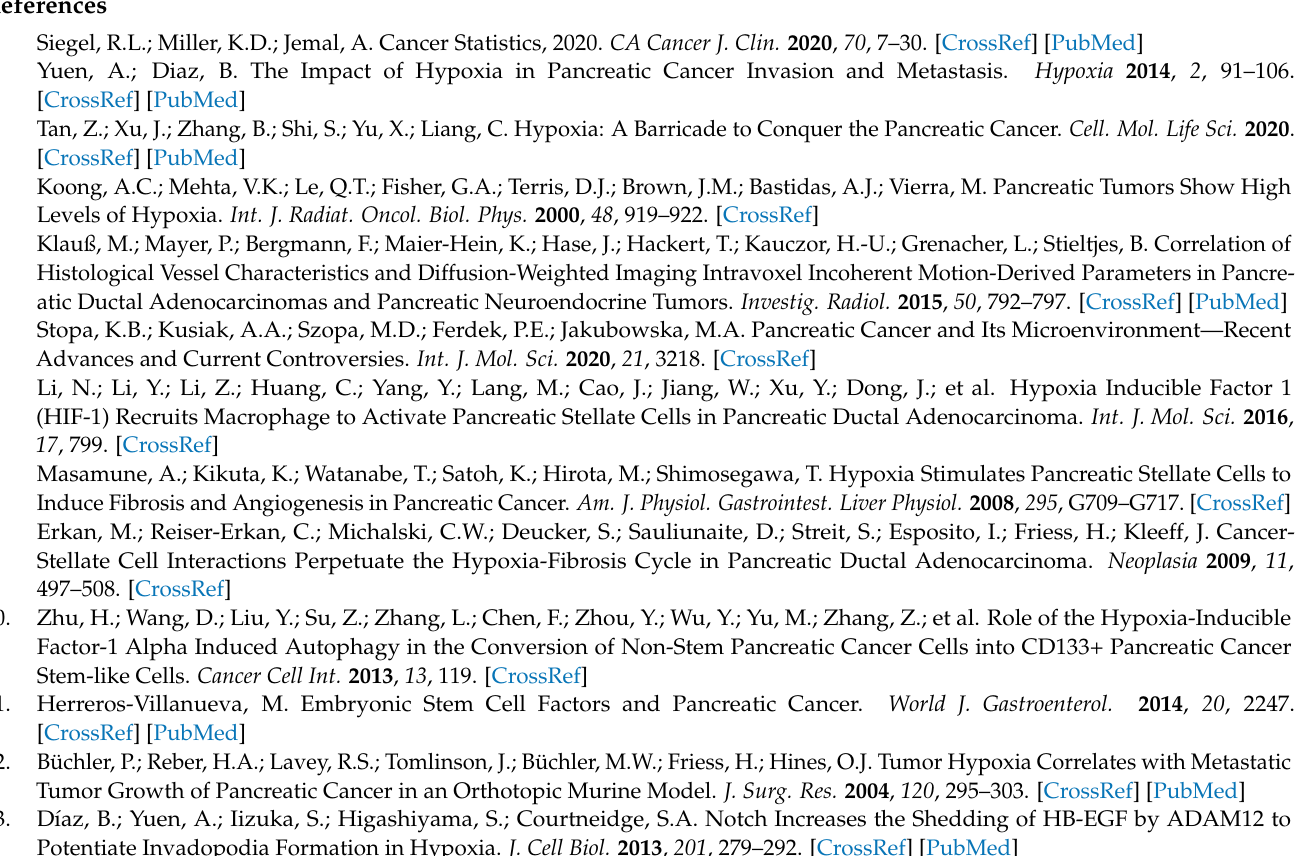
Figure S2: Possible involvement of ERK-pathway on Blimp-1 induction, Figure S3: Progression- free